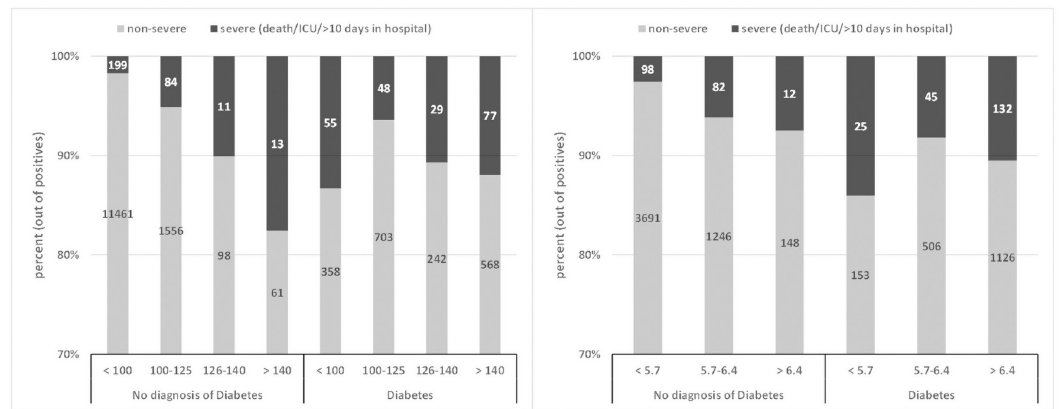
Fig 1. Left (A) : Percentage of severe COVID-19 (death/ICU/ � 10 hospitalization days) given prior fasting glucose range (mg/dl), for patients with no diagnosis of diabetes vs. patients with a diagnosis of diabetes. The numbers on the bars represent the number of patients in each sub-category, whereas the inner partition into red and blue represents the conditional distribution of severity, given the patients are in the specific range of FBG. Right (B): Percentage of severe COVID-19 (death/ICU/ � 10 hospitalization days) given prior HbA1C, for patients with no diagnosis of diabetes (left) vs. patients with a diagnosis of diabetes (right). https://doi.org/10.1371/journal.pone.0254847.g001 mg/dl. The risk of severe infection increased as glucose levels rise above 126 mg/dl, while those with FBG � 105 mg/dl have even more increased risk. This finding was statistically significant in a multivariate logistic regression controlling for age, gender, sector, BMI, HTN, and IHD; Comparing to the (reference) group of FBG 106–126 mg/dl, the group with FBG � 105 mg/dl